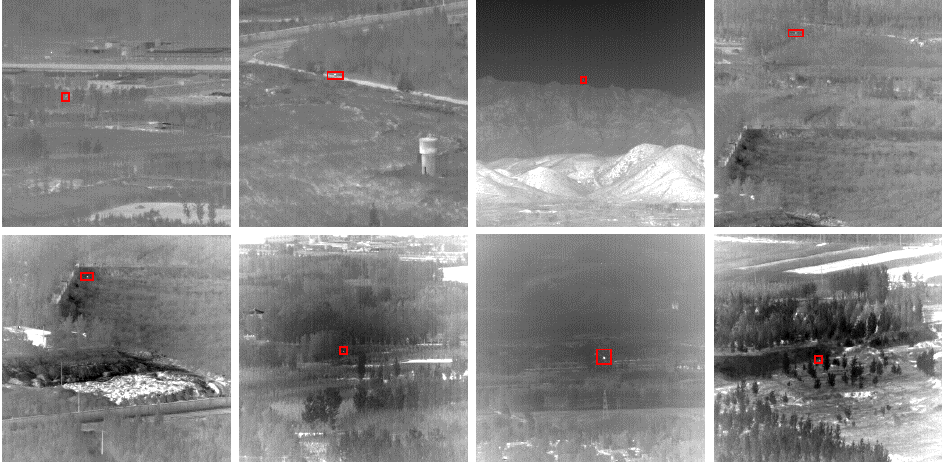
Figure 6. Some images in the experimental dataset. Red boxes mark the real locations of objects. The resolution of the images is 256 ×